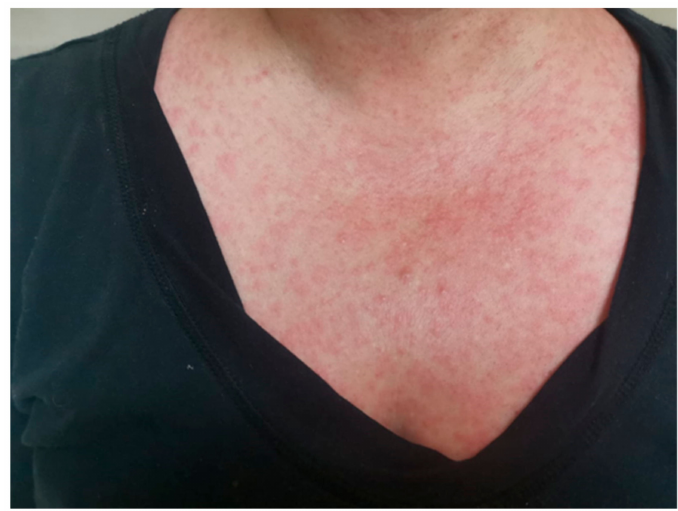
Figure 1. Maculo-papular